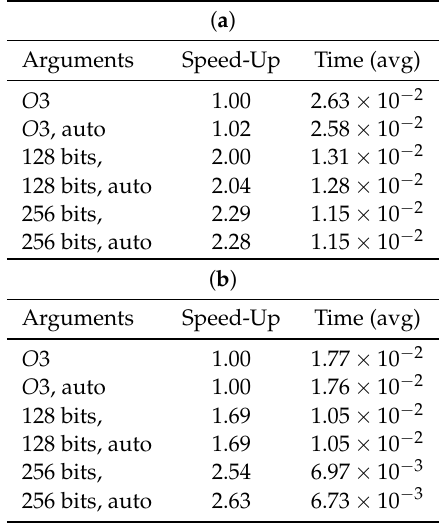
Table 1. Effect of vectorization within the matrix-free operator evaluation. Baseline is given by